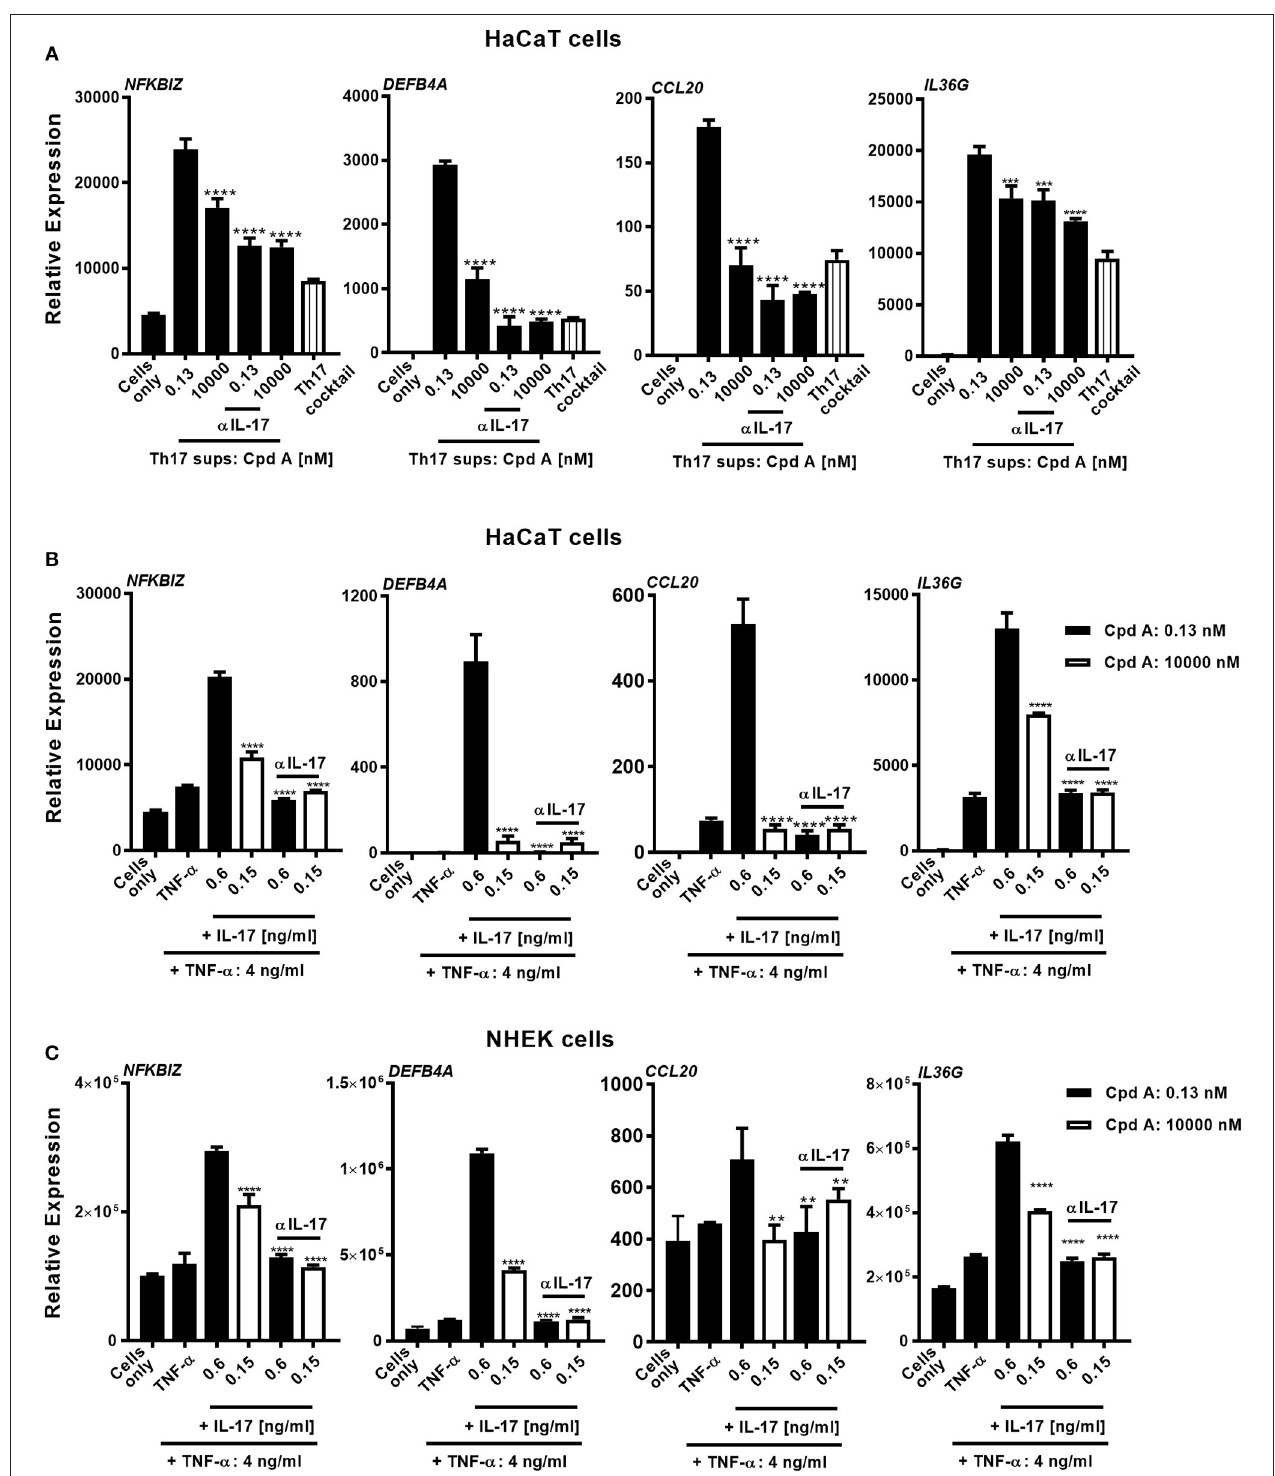
FIGURE 5 | Cpd A attenuates IL-17-induced secondary responses in keratinocytes. (A) HaCaT keratinocytes were cultured for 24h with supernatants derived from Cpd A treated Th17 cells either at a biologically inactive (0.13nM) or at a pharmacologically active concentration (10 µ M). To determine the effect of IL-17 in the conditioned supernatants on the HaCaT cell activation, half of the supernatants were pre-incubated with the IL-17 selective, neutralizing antibody Secukinumab